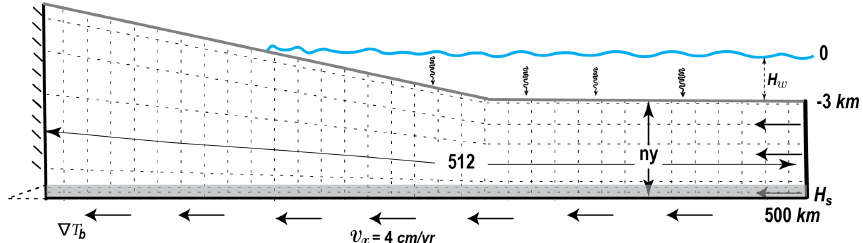
Figure 1. Model setup. Mechanical boundary conditions are a non-deformable backstop on the left side, a constant velocity in the horizontal direction of 4cmyr − 1 ; the top boundary behaves as a free surface above sea level, while the weight of the water column is prescribed as stress normal to the deformed boundary below sea level. Temperature is fixed at the surface; the thermal gradient is prescribed across all other boundaries with the value of zero on vertical ones and value of ∇ T b at the bottom boundary. The mesh consists of 512 × n y Q2P1 elements which deform to adapt to the deforming top boundary. Parameters are defined in Table